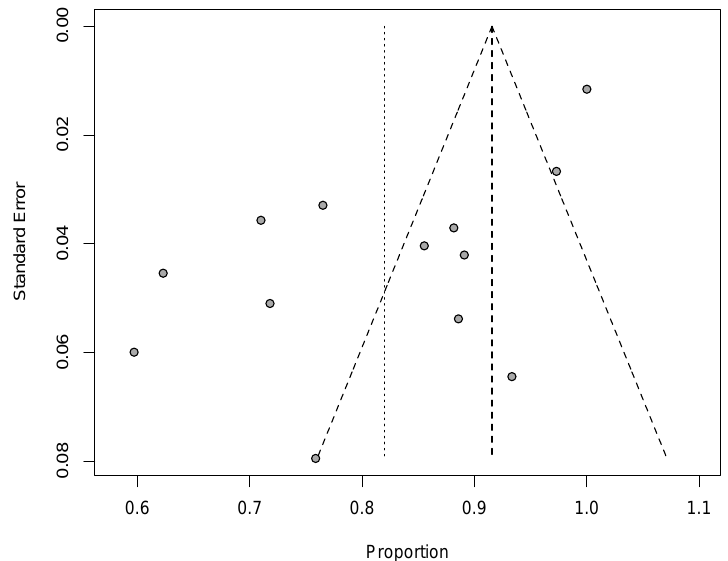
Figure 8. Funnel plot chart evaluating publication bias.